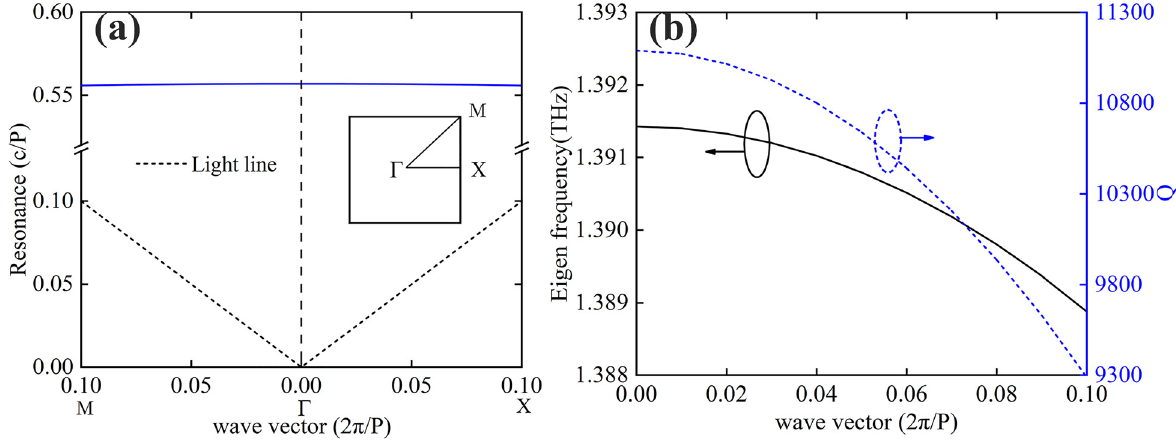
Figure 2: (a) The band structure of the BIC mode supported by the slotted HRSi disk array. The blue line represents the BIC mode, while the dashed lines mark the light dispersion. (b) Resonance eigen frequencies and the associated Q -factors of the BIC mode as a function of the lateral wave